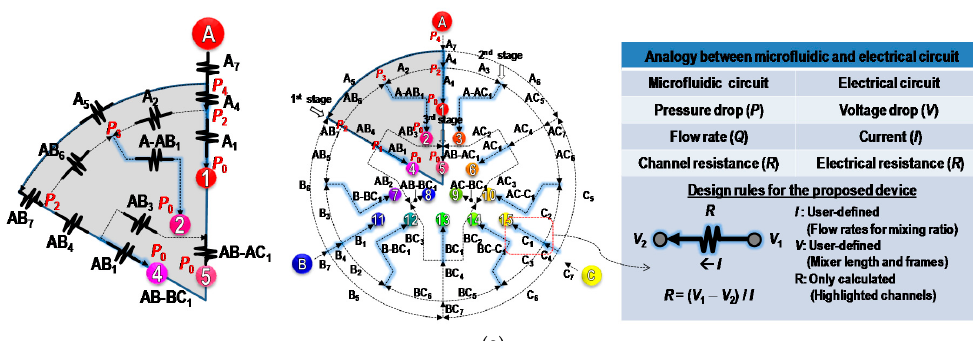
Figure 1. ( a ) The schematic of standard mixture design of experiment (DOE): Simplex lattice design configured by 15 mixture points for three samples (A, B, and C). ( b ) Two-dimensional microfluidic network for the proposed combinatorial dilutions of 15 mixtures by three samples.